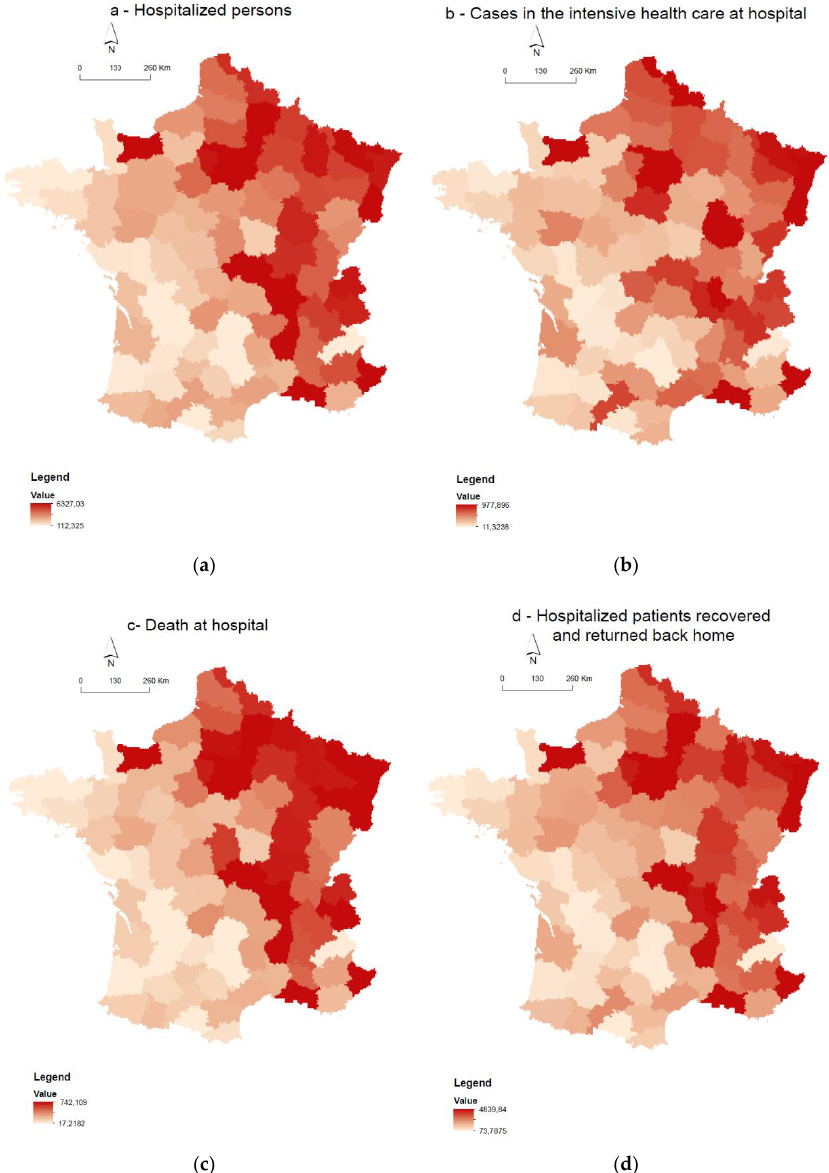
Figure 1. Spatial distribution on the French department scale. ( a ) Rate of death in the hospital for 100,000 inhabitants, ( b ) rate of hospitalized persons for 100,000 inhabitants, ( c ) cases hospitalized in intensive health care for 100,000 inhabitants, and ( d ) rate of hospitalized patients recovered and returned back home for 100,000 inhabitants.